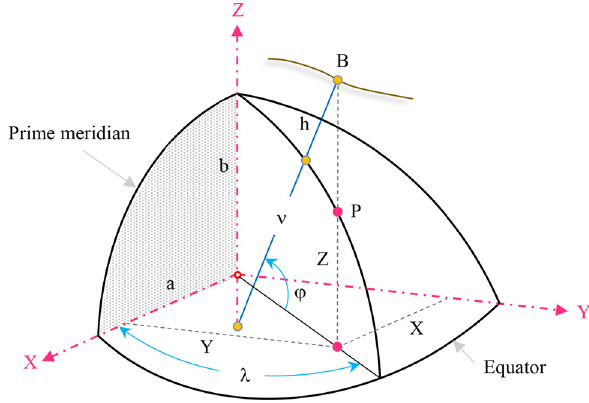
Figure 1: Geodetic and Cartesian coordinate